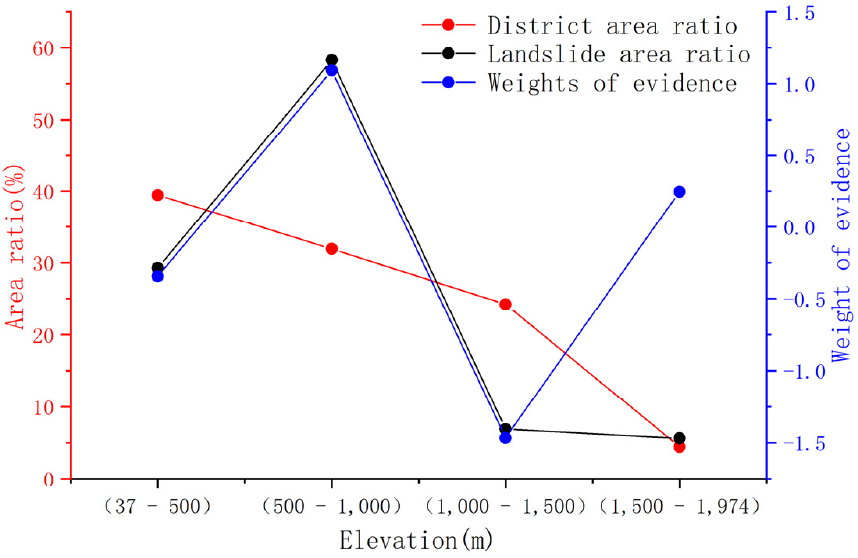
Figure 5. Elevation statistical analysis results.